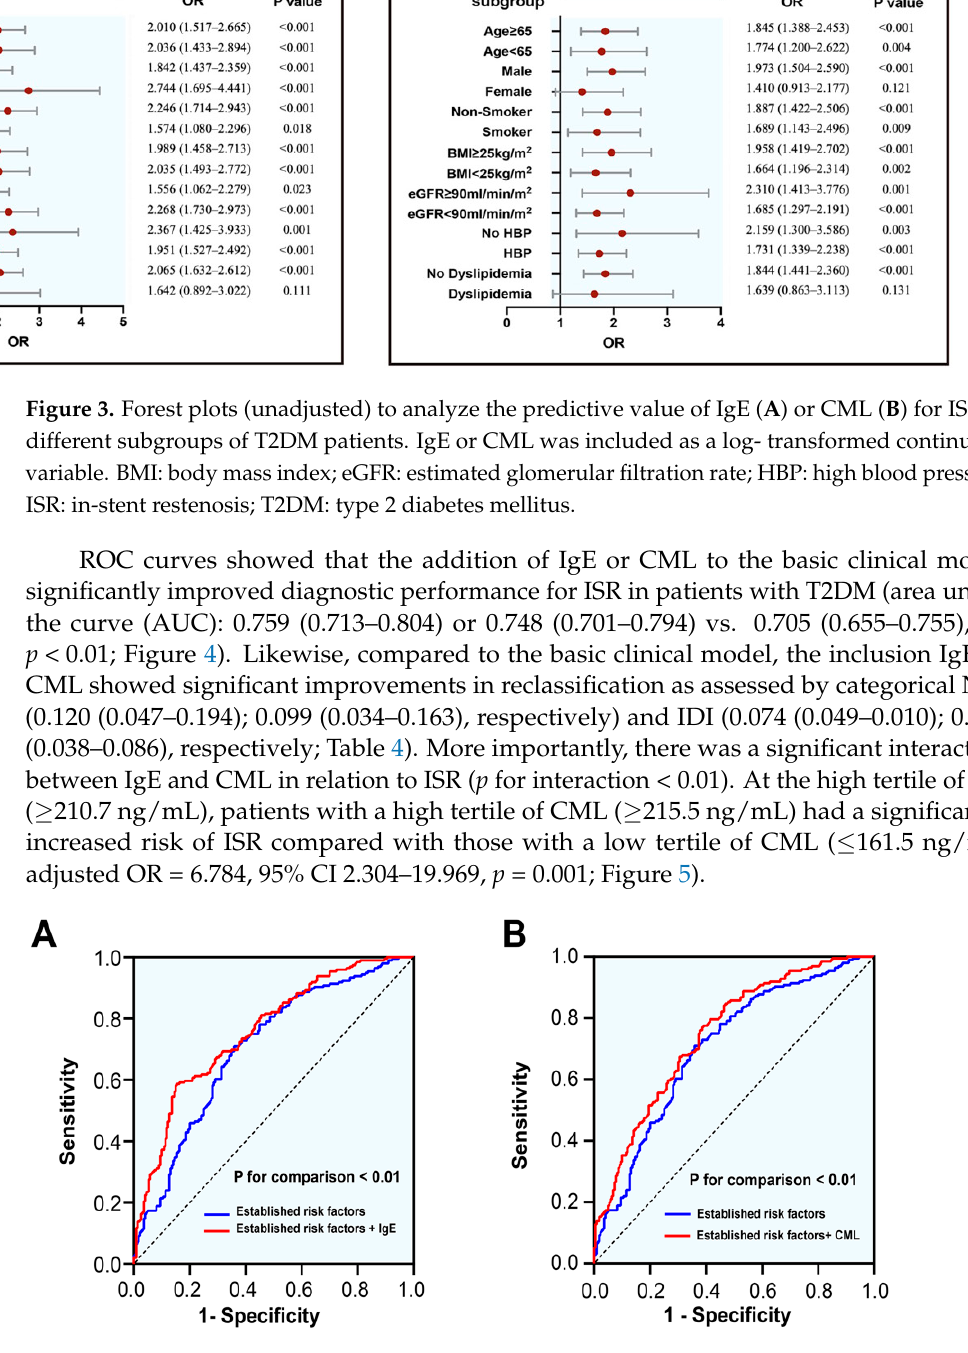
Figure 4. Receiver operating characteristic curve analysis between models to verify the predictive values of IgE ( A ) and CML ( B ). Established risk factors include age, sex, body mass index, smoking, dyslipidemia, hypertension, HbA1c, LVEF, statins use, number of diseased vessels, class B2/C lesions, bifurcation lesions, CTO lesions, and stent diameter. Table 4. The predictive power of models for ISR .